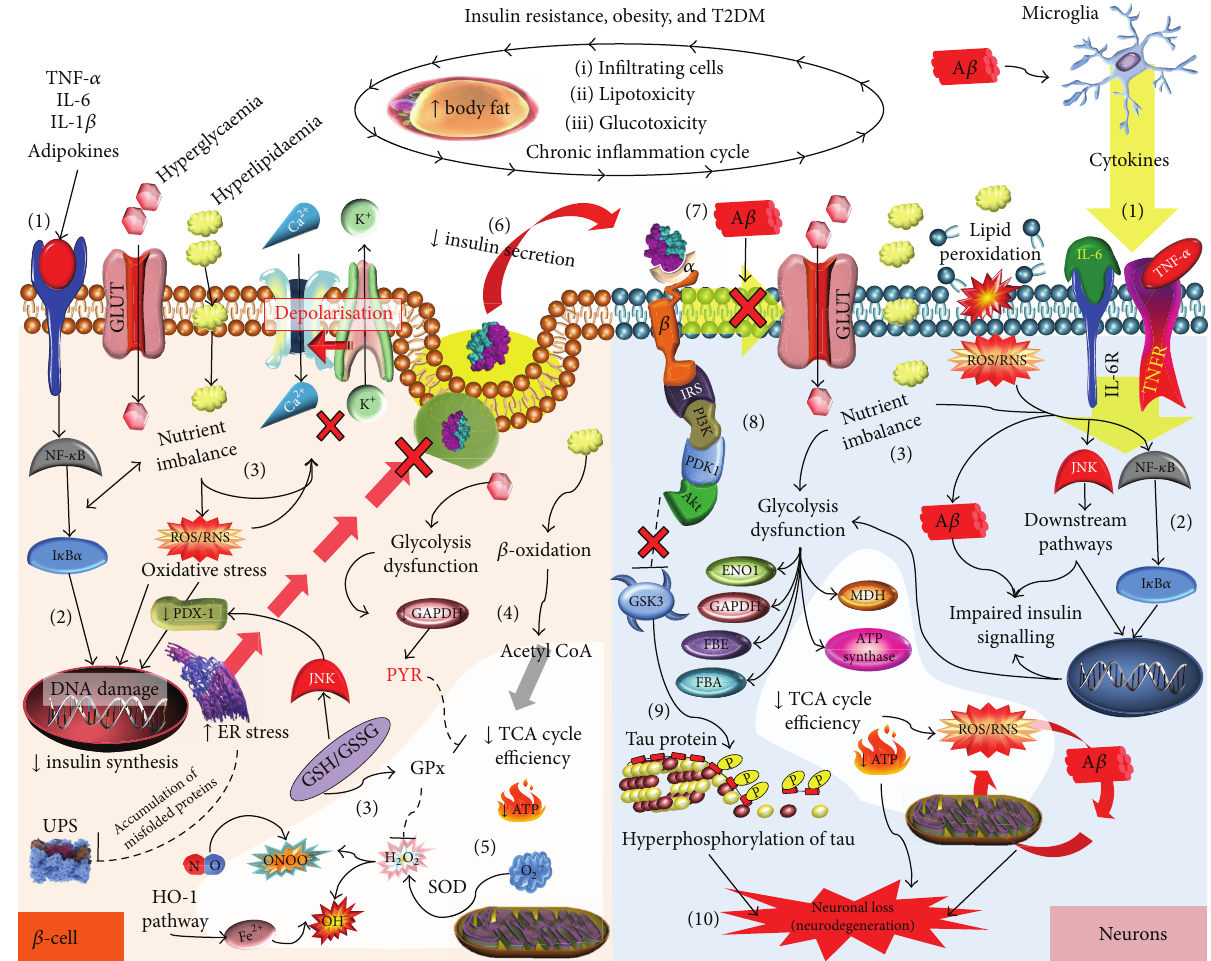
Figure 2: Molecular mechanisms linking insulin resistance with neurodegeneration. Obesity is characterized by chronic low-grade inflammation, which impacts all tissues and organs. Inflammatory cytokines bind to their receptors (1) activating the nuclear factor-kappaB (NF- 𝜅 B/I 𝜅 B 𝛼 ) pathway, which stimulates a proinflammatory condition (2). Nutrient imbalance may also activate inflammatory pathways and DNA damage, adversely impacting redox regulation (via glutathione peroxidase (GPx); glutathione (GSH); and oxidised glutathione (GSSG) levels) and so promoting oxidative stress (3). 𝛽 -cell metabolism and ATP production are affected by nutrient imbalance via glycolytic dysfunction and reduced activation of glyceraldehyde 3-phosphate dehydrogenase (GAPDH) reducing pyruvate (PYR) generation but promoting 𝛽 -oxidation (4). As a result of the metabolic dysfunction, superoxide and subsequently hydrogen peroxide generation (which can combine with nitric oxide, NO, to create peroxynitrite, an example of RNS) may occur due to compromised mitochondrial electron transport chain, ETC, and action, and so reducing ATP synthesis (5). All these processes impact endoplasmic reticulum (ER) stress, leading to a reduction in the ability to secrete insulin (6). High circulating levels of lipids and glucose and chronic inflammation increase amyloid beta (A 𝛽 ) aggregation, which together with low insulin reduce the transport and utilisation of glucose in the brain (7) via impairment in insulin signalling (8), including the negative regulator of glycogen synthase kinase 3 (GSK3). Activated GSK3 is associated with tau hyperphosphorylation (9). The vicious cycle mediated by ROS/RNS and A 𝛽 may eventually result in enzyme inhibition (e.g., alpha-enolase (ENO1), malate dehydrogenase (MDH), ATP synthase, and GAPDH), lowering ATP generation, which together with tau promotes neuronal loss (10). Protein kinase B (AKT); fructose bisphosphate enolase (FBE); fructose bisphosphate aldolase (FBA); calcium (Ca 2+ ); iron (Fe 2+ ); glucose transporters (GLUT); hydrogen peroxide (H 2 O 2 ); interleukin- (IL-) 1 and interleukin- (IL-) 6; insulin receptor substrate (IRS); Janus kinase (JNK); potassium (K + ); nitric oxide (NO); anion superoxide (O 2− ); hydroxyl radical (OH − ); peroxynitrite (ONOO − ); pyruvate dehydrogenase kinase, isozyme 1 (PDK1); pancreatic and duodenal homeobox 1 (PDX-1); Phosphatidylinositol-4,5-bisphosphate 3-kinase (PI3K); superoxide dismutase (SOD); tumour necrosis factor alpha (TNF- 𝛼 ); ubiquitin-proteasome system